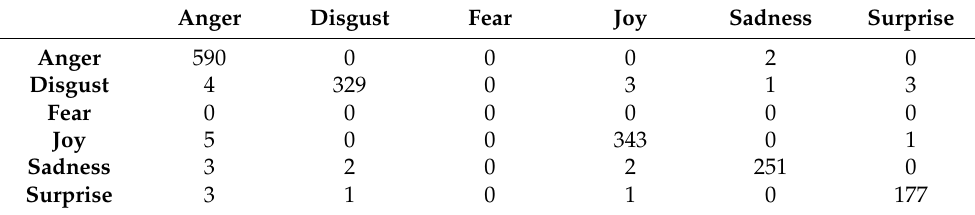
Table 2. Model’s confusion